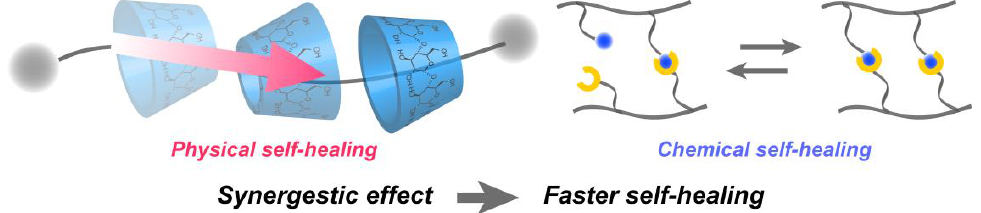
Figure 2. Schematic illustration of the fast self-healing of supramolecular gel by the synergistic ef-